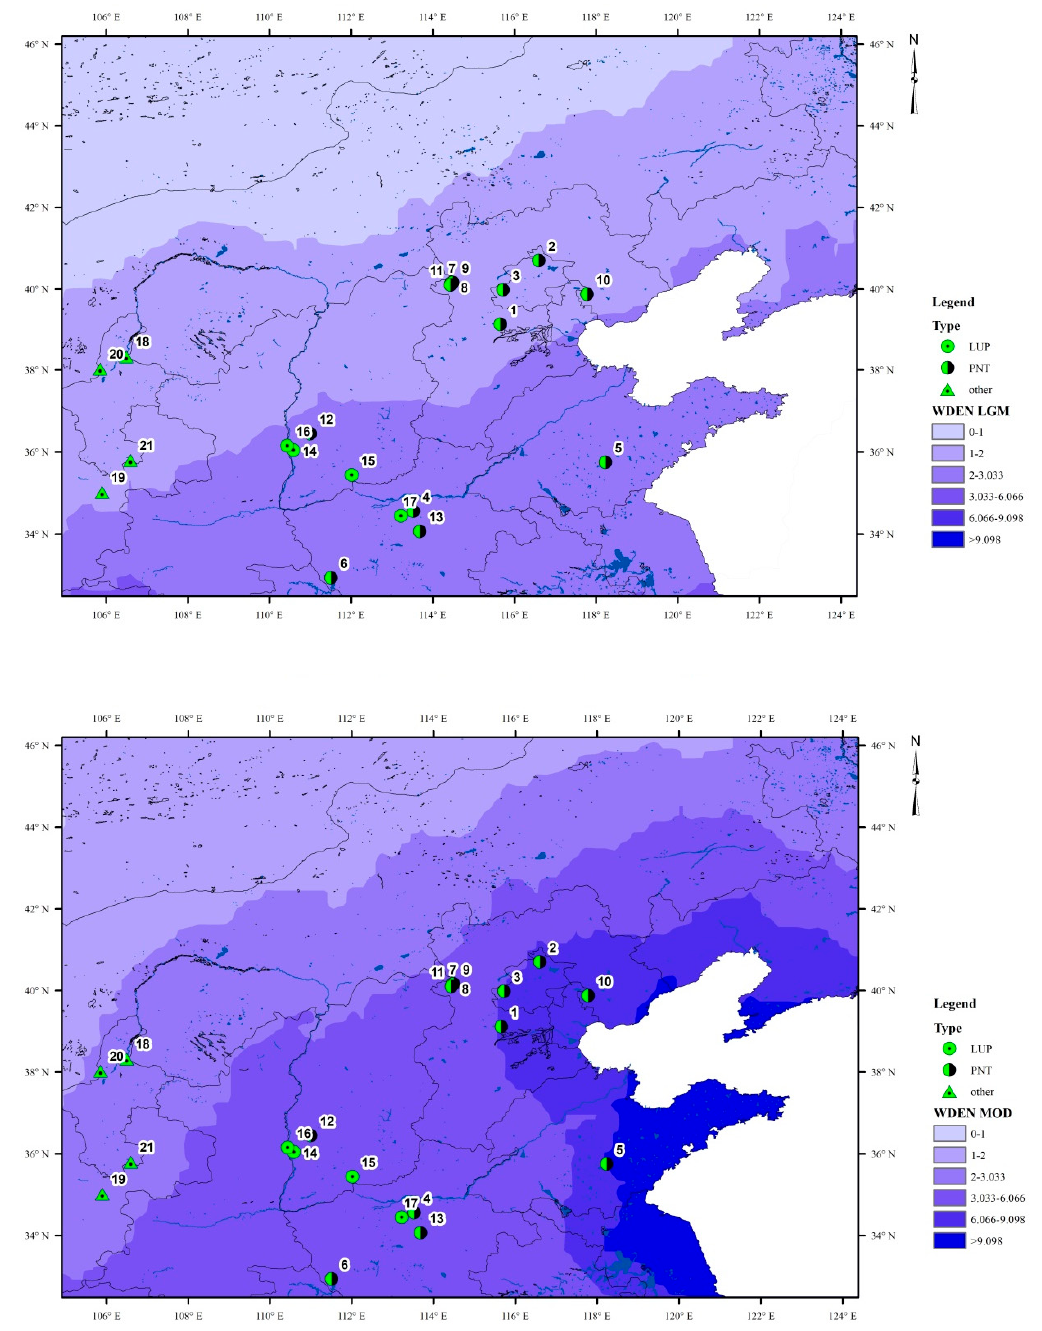
Figure 8. Archaeological sites dated to the Pleistocene to Holocene transition on the maps of projected HG population density (WDEN) of northern China under LGM and modern climatic conditions.